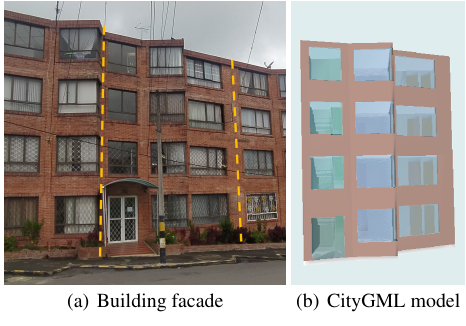
Figure 2. Reality vs. CityGML